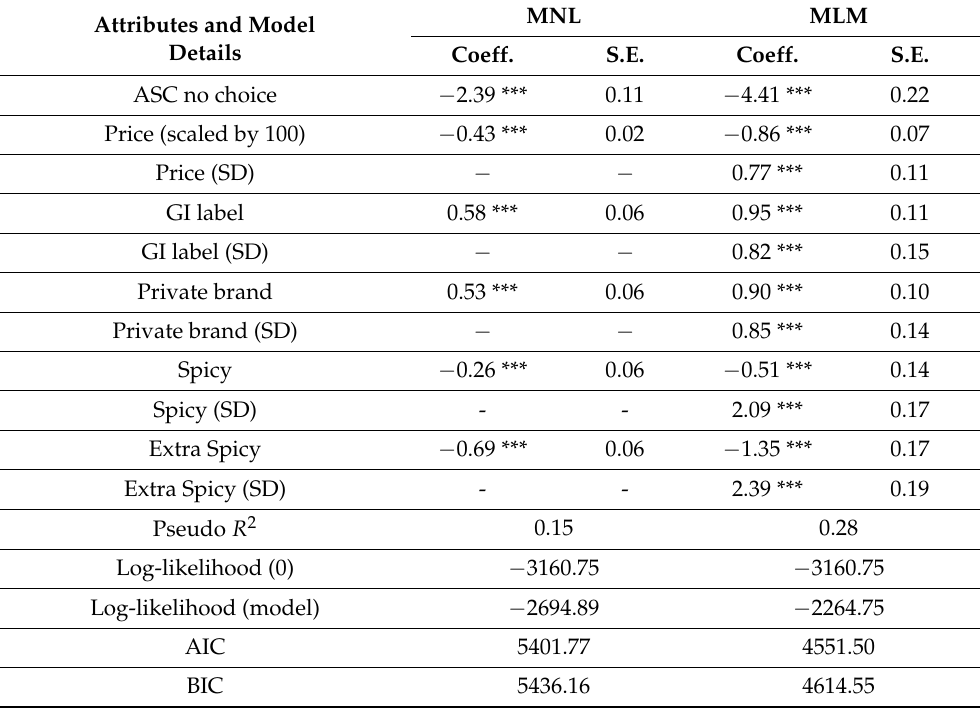
Table 4. Coefficient estimates by multinomial logit and mixed logit models. Attributes and